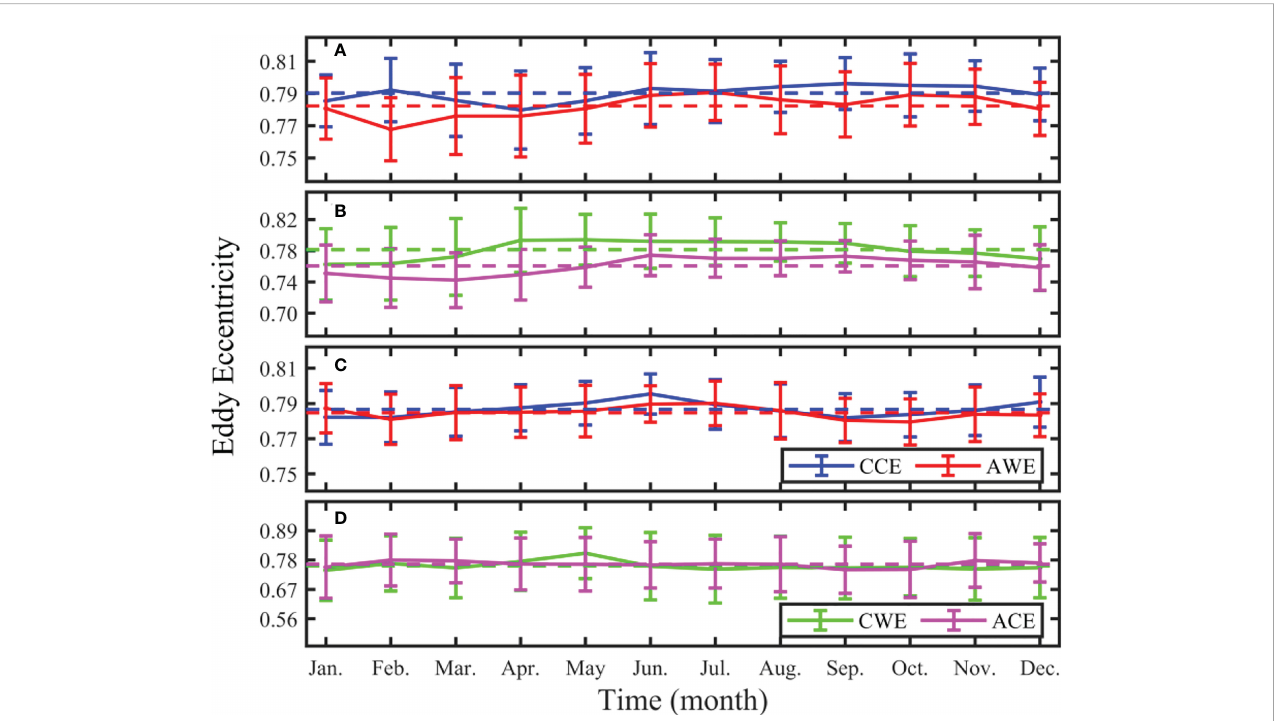
FIGURE 7 Monthly distribution of multi-year (2008 ~ 2017) average eddy eccentricity at the sea surface (A, B) and 1,000 m (C, D) in the STCC area. Blue, red, pink, and green curves represent cyclonic cold-core eddy, anticyclonic warm-core eddy, cyclonic warm-core eddy, and anticyclonic cold-core eddy, respectively. The vertical line represents the standard deviation, and the dotted line represents the multi-year average